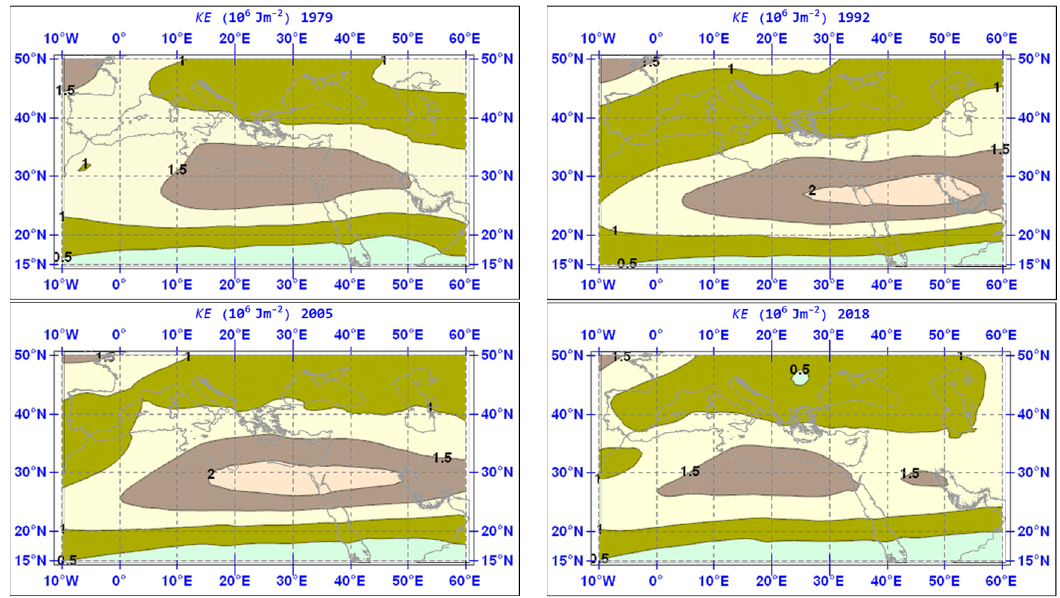
Figure 4. The annual mean spatial distribution of KE for selected years. Isopleths are drawn for every 0.5 × 10 6 Jm − 2 .